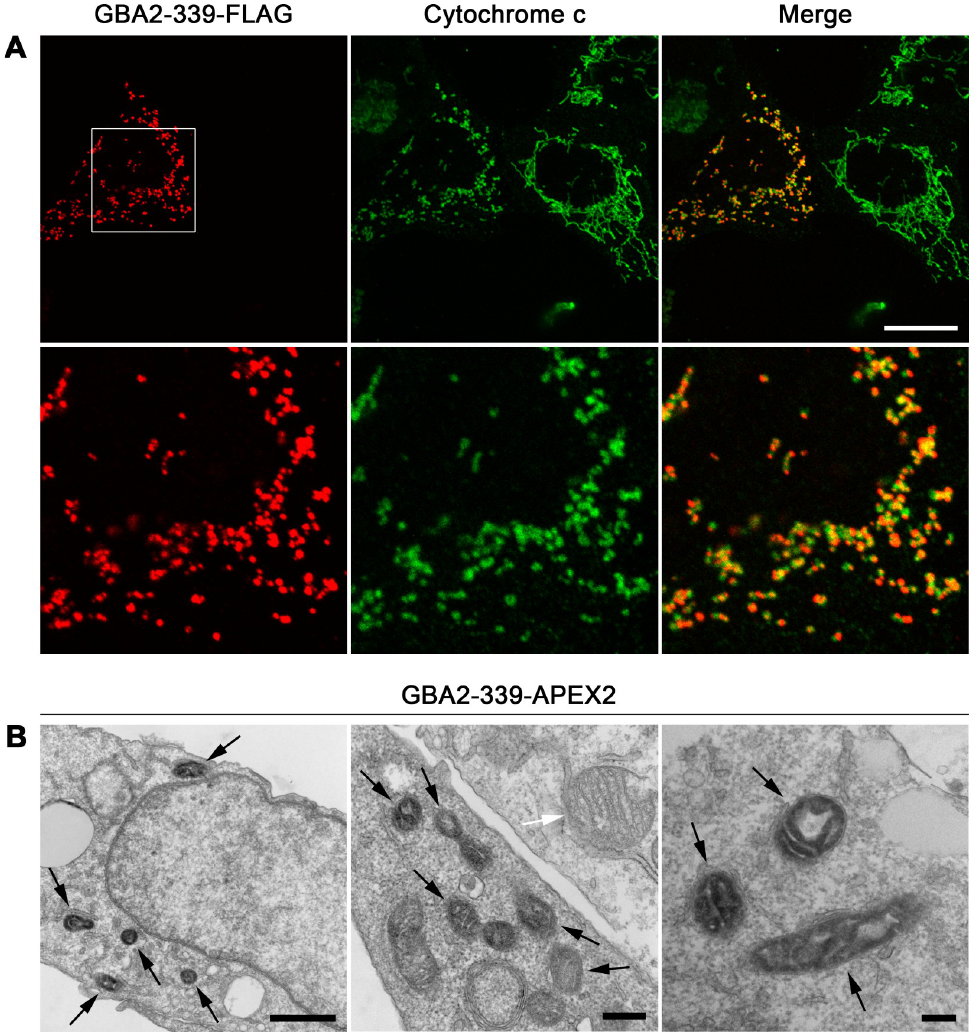
Fig 5. GBA2-339 is localized in the mitochondrial matrix and promotes mitochondrial fragmentation. (A) U2OS cells transfected with a cDNA coding for GBA2-339-FLAG were immunostained with anti-FLAG (red) and anti- cytochrome c antibodies (green). A section (white square) of the images in the upper panels is enlarged in the lower panels. Scale bar, 20 μ m. (B) Localization of APEX2-tagged GBA2-339 by electron microscopy. Black arrows point to APEX2-stained mitochondria, and the white arrow points to a non-APEX2-stained mitochondrion. Scale bars: left panel, 1000 nm; middle panel, 400 nm; right panel, 200